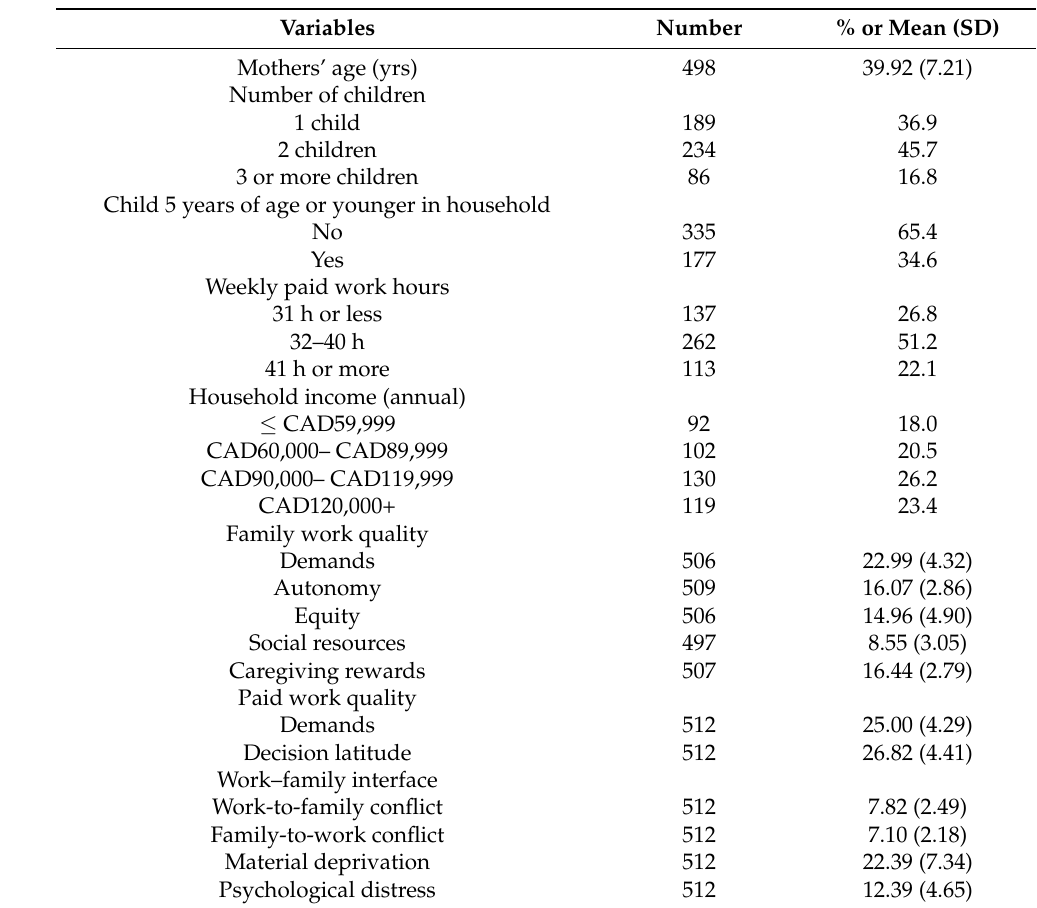
Table 1. Characteristics of the study population ( n = 512).